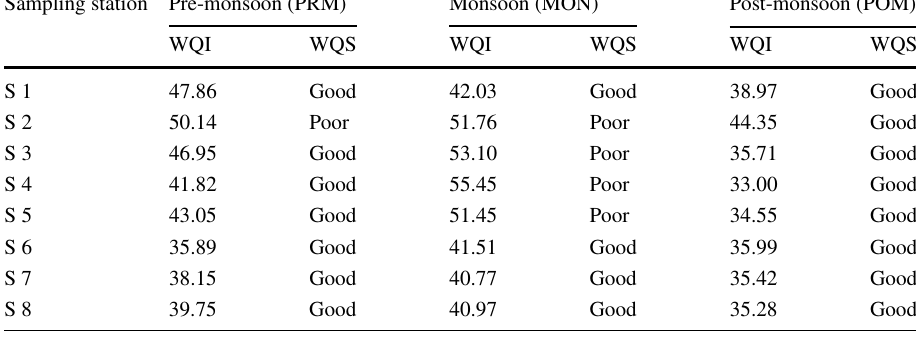
Table 14 Seasonal WQI of Doyang River with its water quality status (WQI)